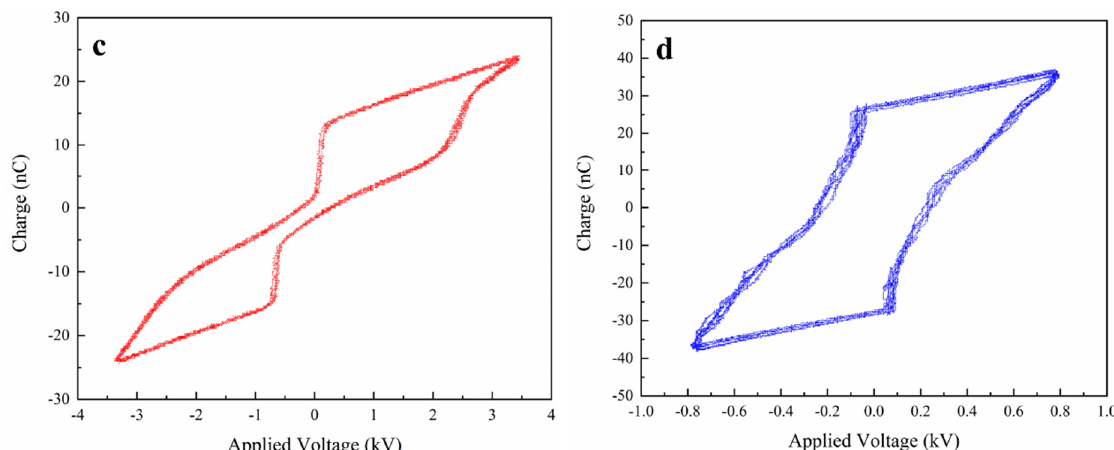
Figure 1. Schematical representation of the ( a ) APPJ set ‐ up used to treat polymer solutions and ( b ) DBD set ‐ up used to treat nanofibrous scaffolds (the insets in ( a ) and ( b ) show photographs of the APPJ treatments of polymer solution and the DBD treatment of the resultant nanofibrous scaffold, respectively); Q ‐ V Lissajous figures of the ( c ) APPJ and ( d ) DBD discharge.